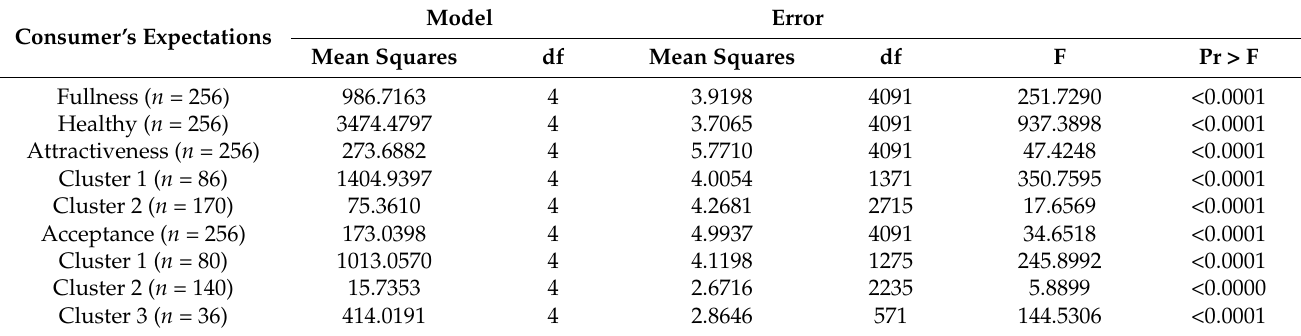
Table 7. ANOVA to test significant differences between attributes-level combinations in the consumer’ expectations. Consumer’s Expectations